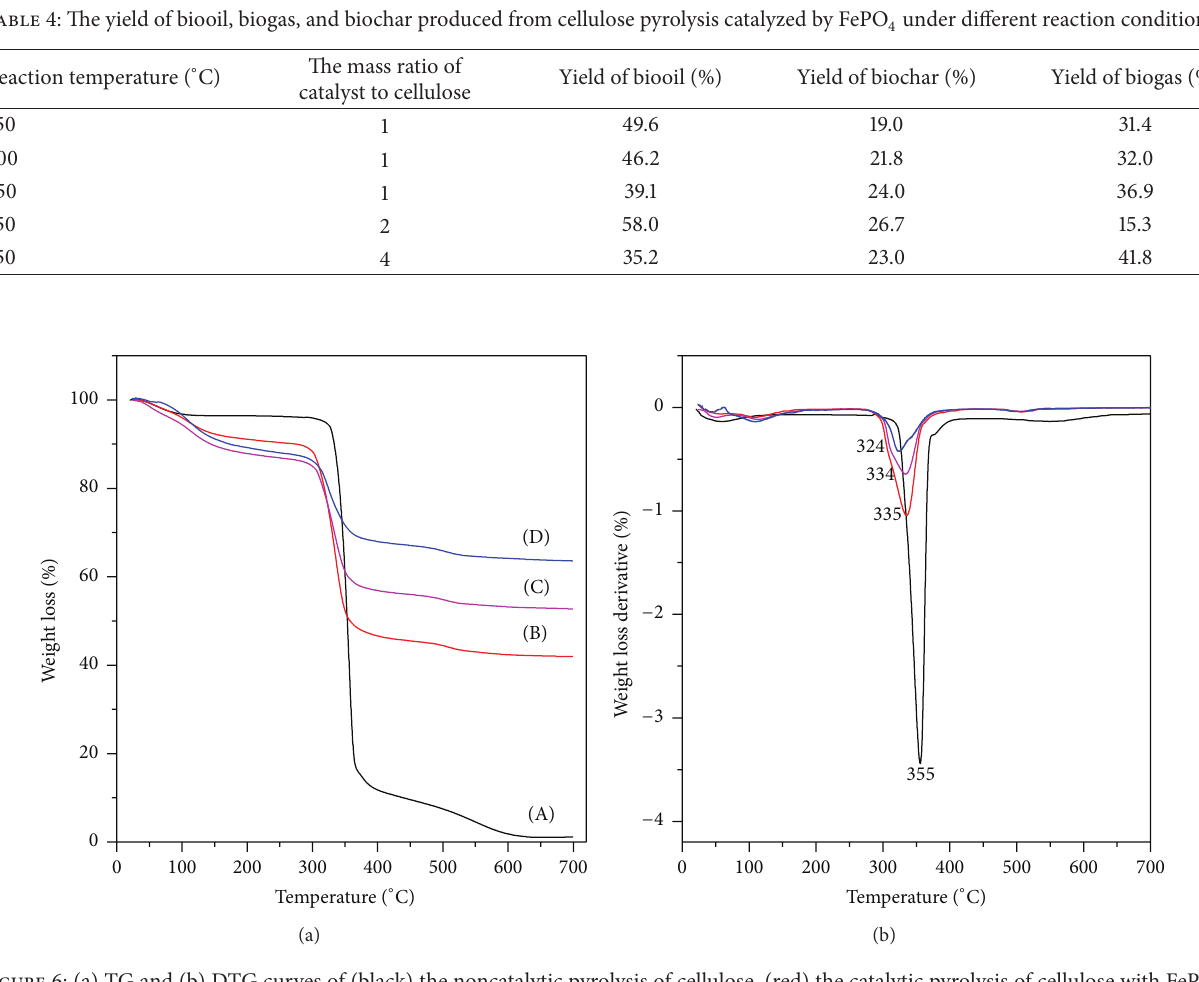
Figure 6: (a) TG and (b) DTG curves of (black) the noncatalytic pyrolysis of cellulose, (red) the catalytic pyrolysis of cellulose with FePO 4 ( 𝑚 (FePO 4 )/ 𝑚 (cellulose) = 1), (magenta) the catalytic pyrolysis of cellulose with FePO 4 ( 𝑚 (FePO 4 )/ 𝑚 (cellulose) = 2), and (blue) the catalytic pyrolysis of cellulose with FePO 4 ( 𝑚 (FePO 4 )/ 𝑚 (cellulose) =